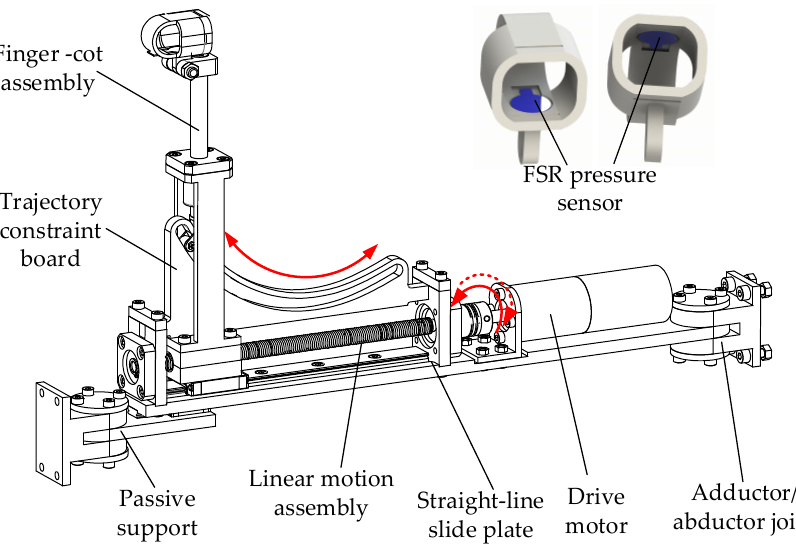
Figure 2. Flexion/extension motion component.